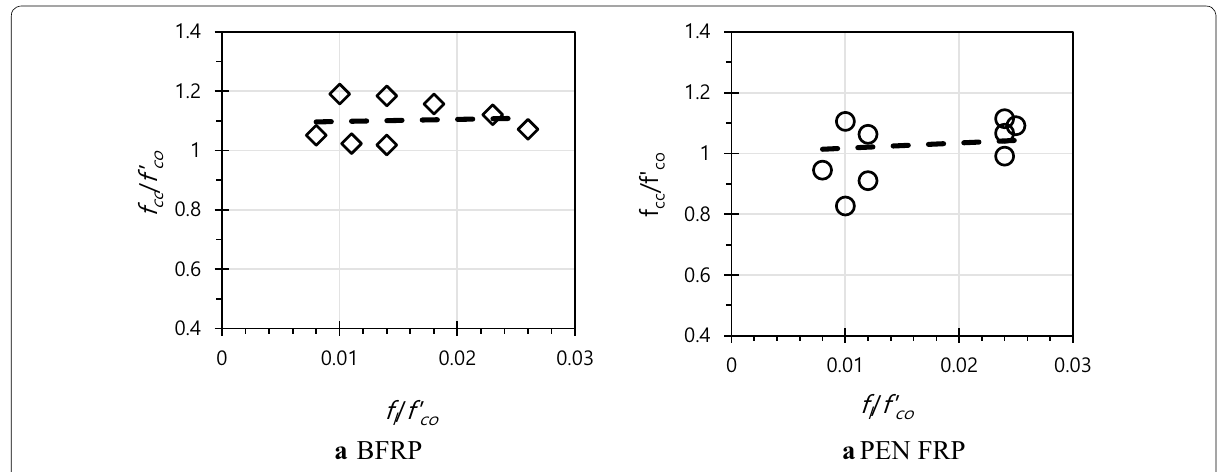
Fig. 14 Relationship of confinement pressure and strength of confined concrete at ε co .